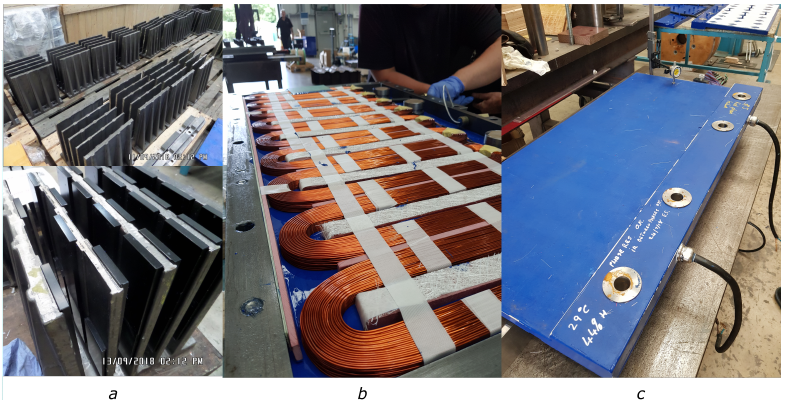
Figure 2. Photos of the C-GEN linear generator modular parts: ( a ) modules of the translator, ( b ) stator coils during production and ( c ) the finished stator blade of the coils in